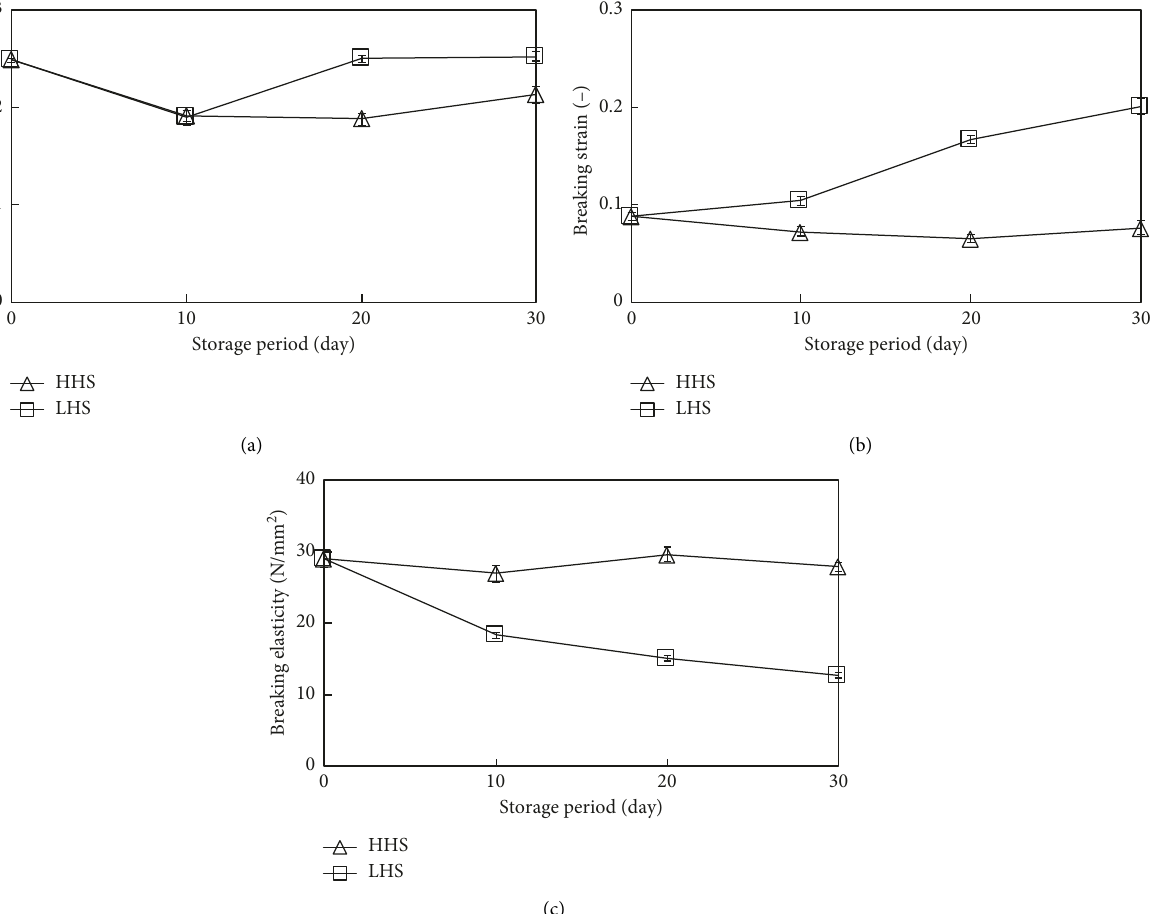
Figure 2: Changes in mechanical properties of “Shine Muscat” fruit during storage: (a) breaking stress; (b) breaking strain; (c) breaking elasticity. HHS: high storage humidity sections; LHS: low storage humidity sections. Error bar shows standard error ( n �